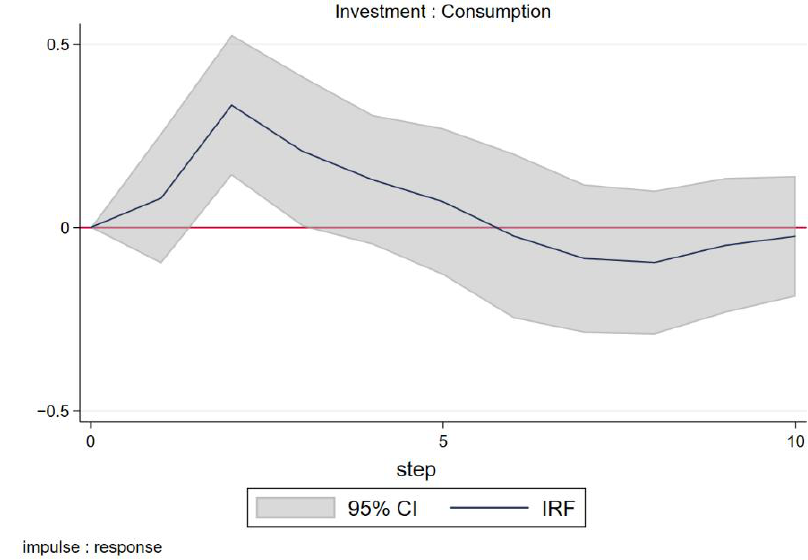
Figure 2. Impulse response of consumption to investment.